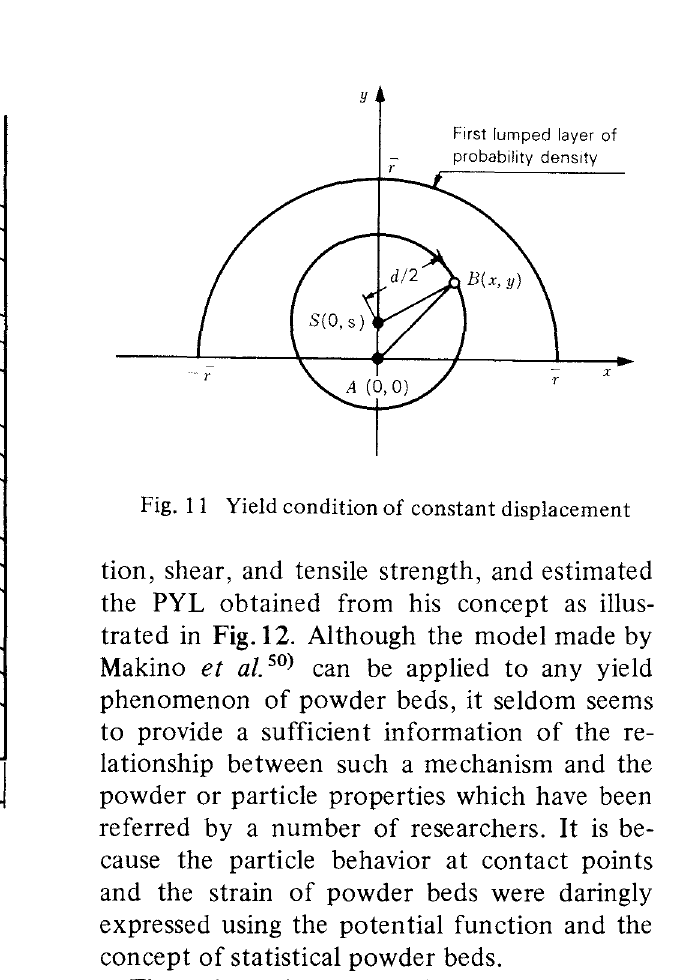
Fig. 11 Yield condition of constant displacement